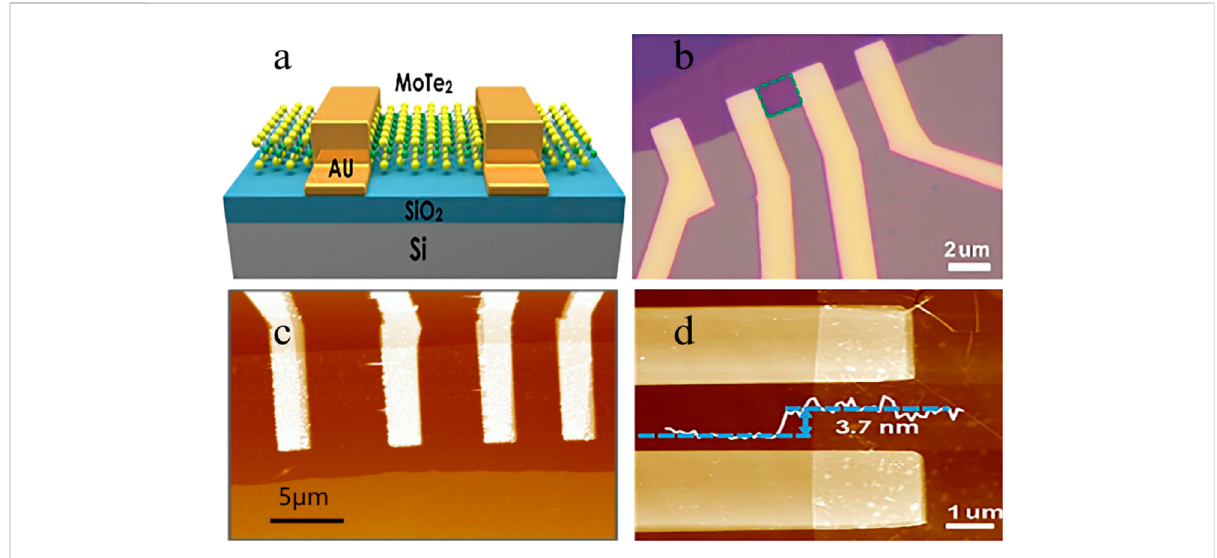
FIGURE 1 (A) Schematic diagram of MoTe 2 transistor. (B) Optical image of the device. Scale bar is 2 μ m. The sensing channel is highlighted by the green dashed rectangle. (C) Atomic force microscopy (AFM) topography image of the MoTe 2 FET. Thickness of the MoTe 2 is 3.4 nm. (D) AFM image of the device. The white curve is an AFM height pro fi